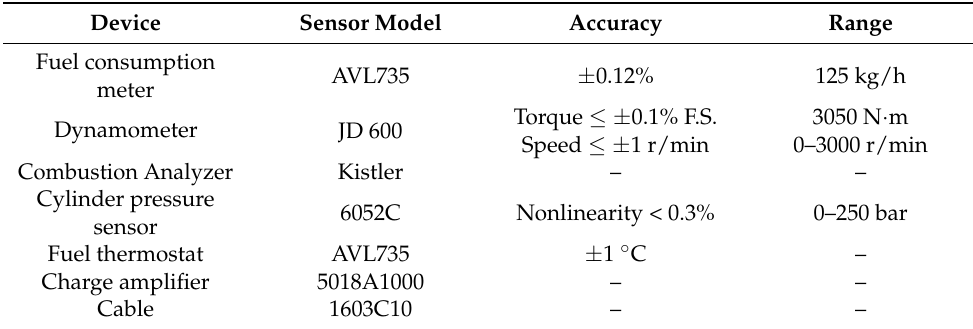
Table 3. Test cycle